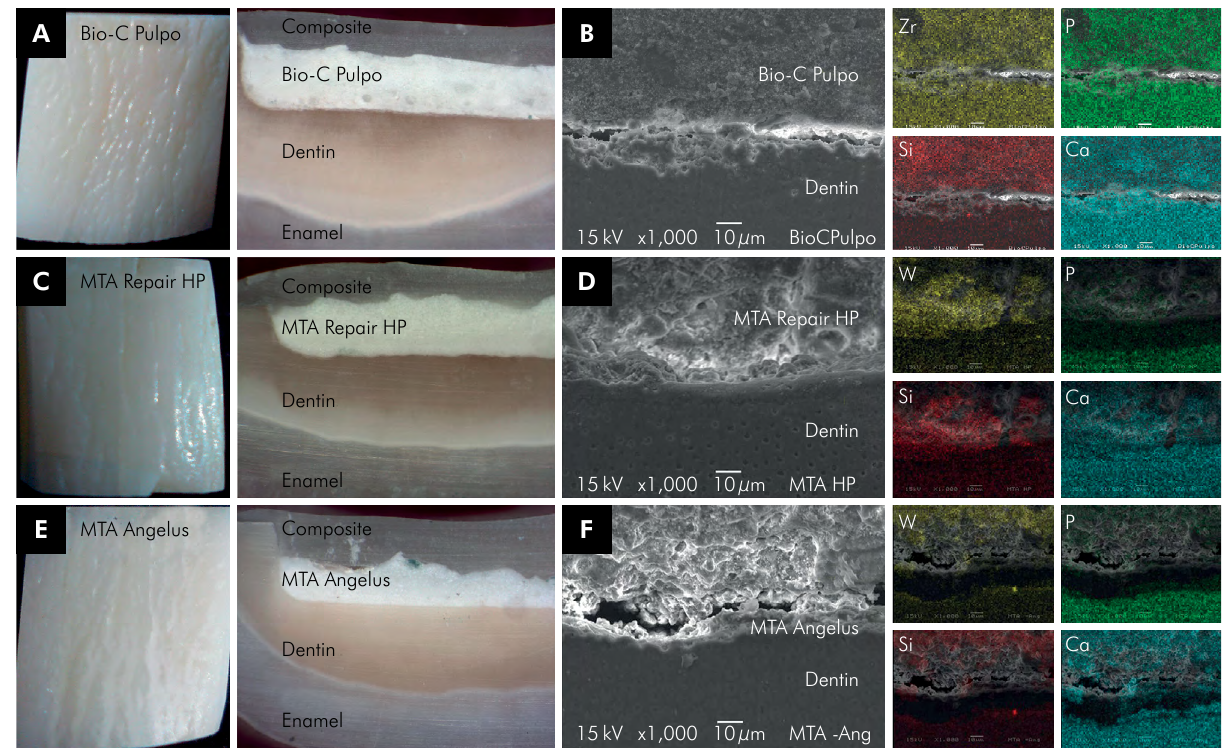
Figure 1. (a, c, e) Representative specimens of bovine teeth filled with cement after 90-day immersion, and stereomicroscopic images of transversal cuts at 2x magnification. (b, d, f) Scanning electron micrographs and overlapped elemental maps of sectioned teeth filled with the tested materials. Calcium (Ca), silicon (Si), and phosphorous (P) were found in all the specimens. In an EDS analysis, phosphorus (P) and zirconium (Zr) ions overlapped in Bio-C Pulpo samples, representing a disadvantage of this analysis when both ions are present. Tungsten (W) ions were present in MTA Repair HP and MTA Angelus cement matrix, and in the adjacent dentin, since these two compositions contain calcium tungstate as a radiopacifier..